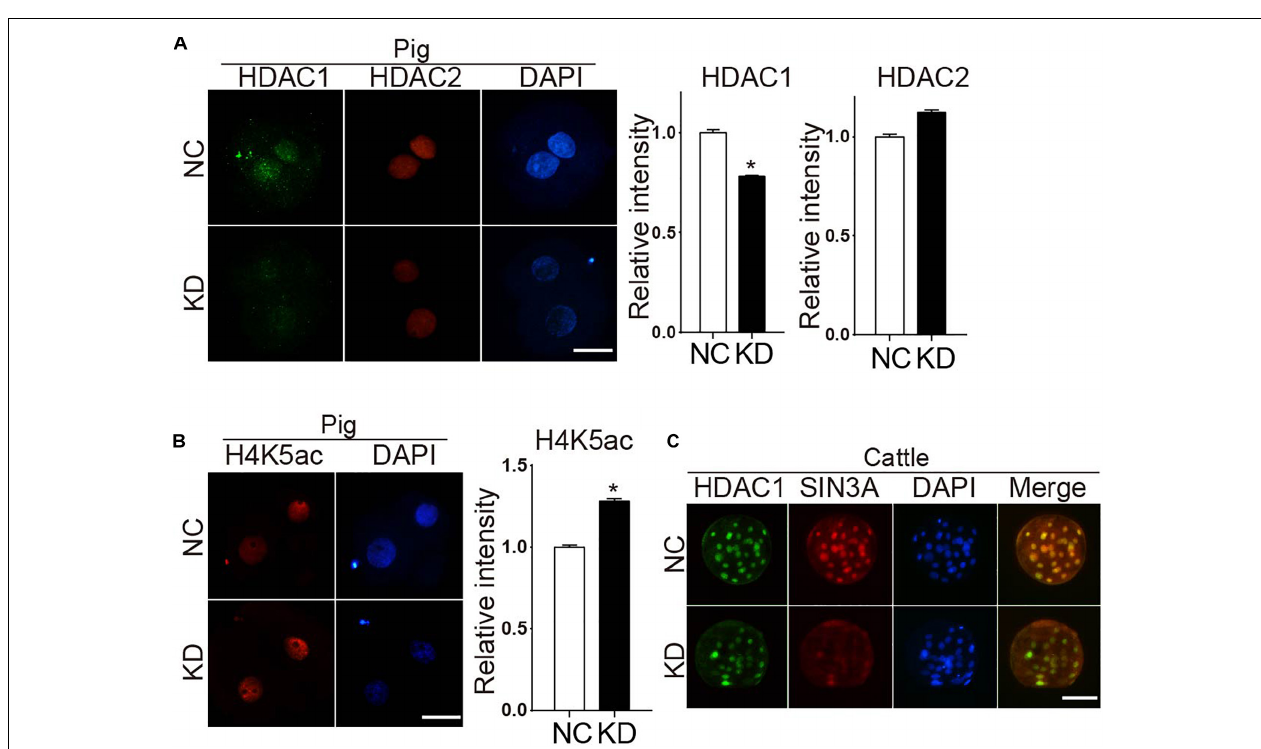
FIGURE 4 | Knockdown of SIN3A results in a slight decrease of HDAC1 in porcine two-cell embryos but not affect the expression of HDAC1 in bovine morula embryos. (A) Immunofluorescence staining was performed to analyze the levels of HDAC1 and HDAC2 signal in SIN3A KD and NC groups at two-cell stage. Representative fluorescence images are shown (left). HDAC1 (green), HDAC2 (red), nuclei (blue). Average value of fluorescence intensities of HDAC1 and HDAC2 was assessed by densitometry (right). The experiment was independently repeated three times, and data was indicated as mean ± SEM. * P < 0.05. (B) The level of H4K5ac after SIN3A KD was detected by immunofluorescence staining in porcine two-cell embryos (left). H4K5ac (red), nuclei (blue). Quantitative analysis of fluorescence values showed that the expression level of H4K5ac was significantly reduced in pig two-cell embryos with SIN3A knockdown (right). The experiment was independently repeated three times, and data was indicated as mean ± SEM. * P < 0.05. (C) Immunofluorescence staining results of the HDAC1 in the bovine morula embryos from NC and SIN3A-KD groups. HDAC1 (green), SIN3A (red), nuclei